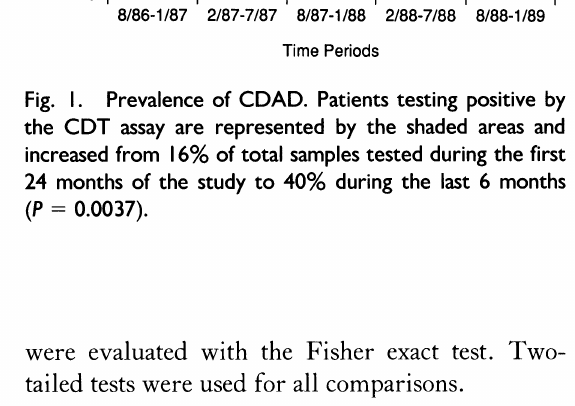
were evaluated with the Fisher exact test. Two- tailed tests were used for all